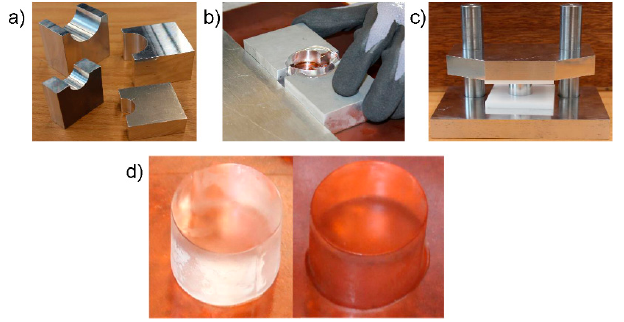
Figure 1. ( a , b ) aluminum forms used in the forming of the specimen; ( c ) the jig used to ensure the parallelism of the specimen loading surfaces (the aluminum cylinder at the center illustrates the specimen); ( d ) examples of specimens ready for